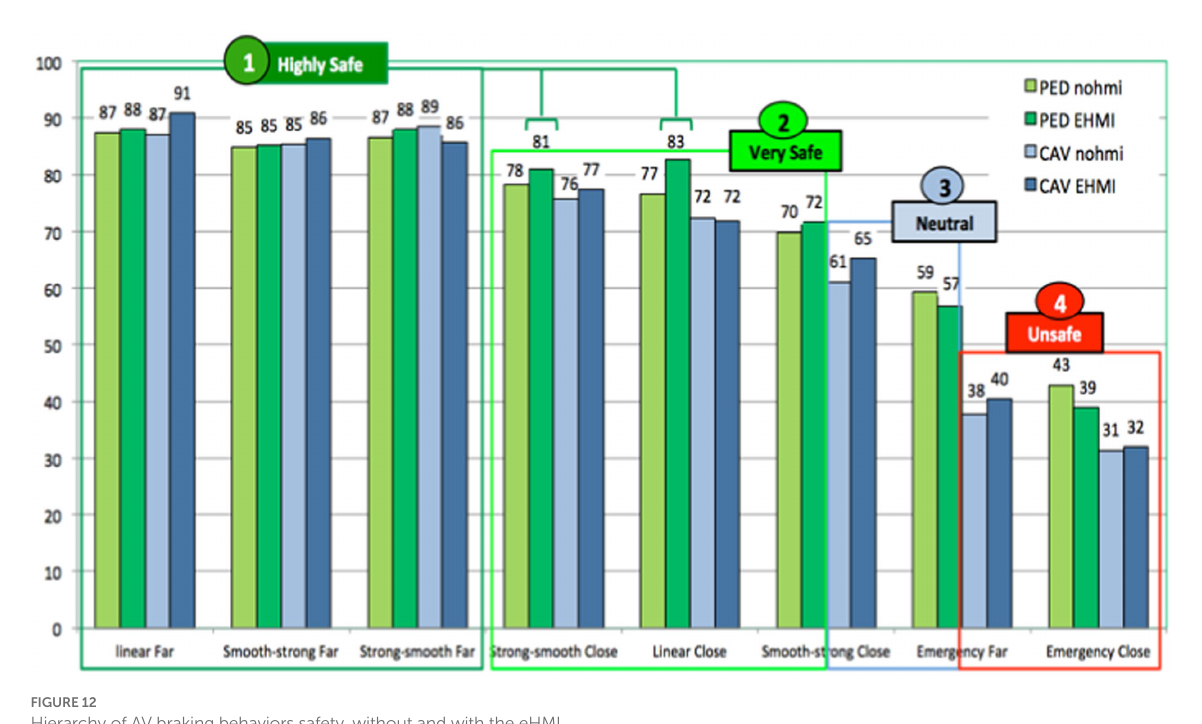
FIGURE 12 Hierarchy of AV braking behaviors safety, without and with the eHMI.